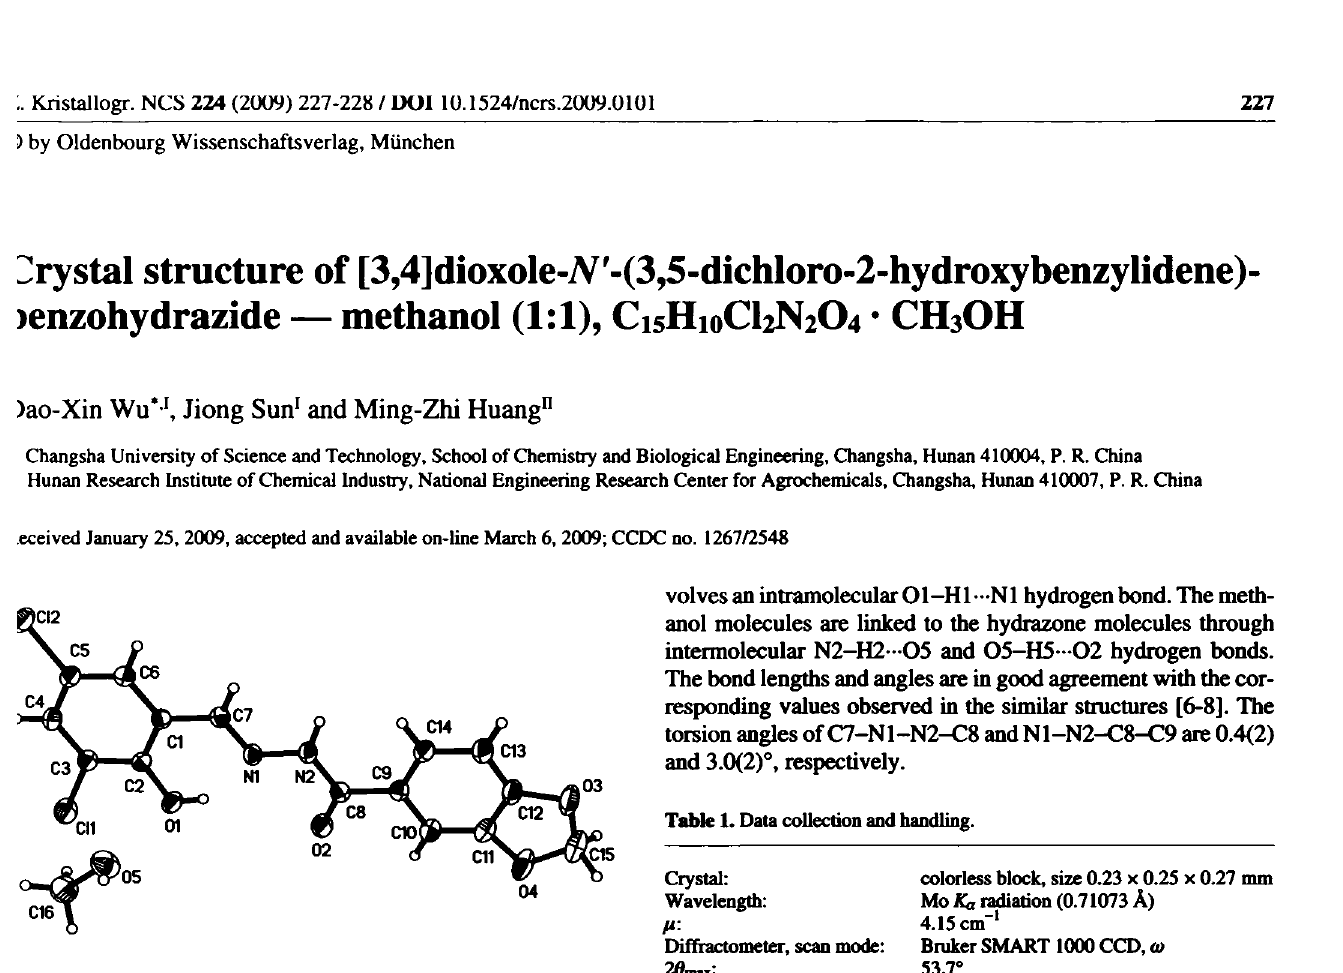
Table 2. Atomic coordinates and displacement parameters (in Â 2